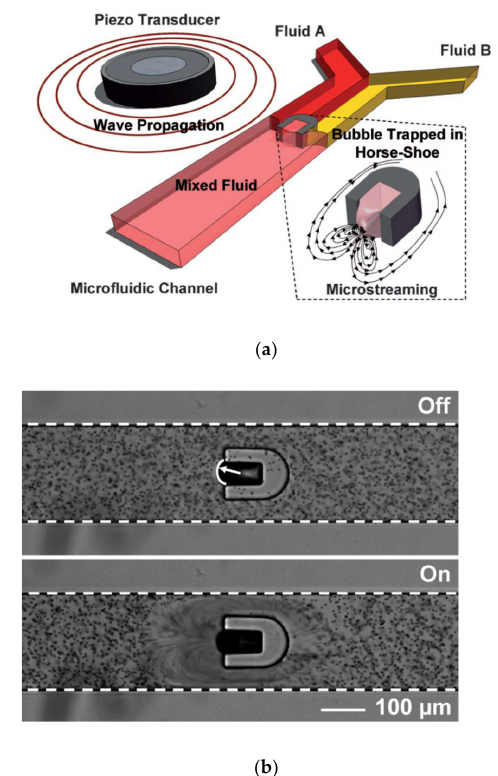
Figure 7. ( a ) Schematic representation of horse shoe piezo transducer setup in a microfluidic system to induce mixing and ( b ) experimental visualisation of enhanced mixing when transducer is on vs. off. Reproduced with permission from [42].